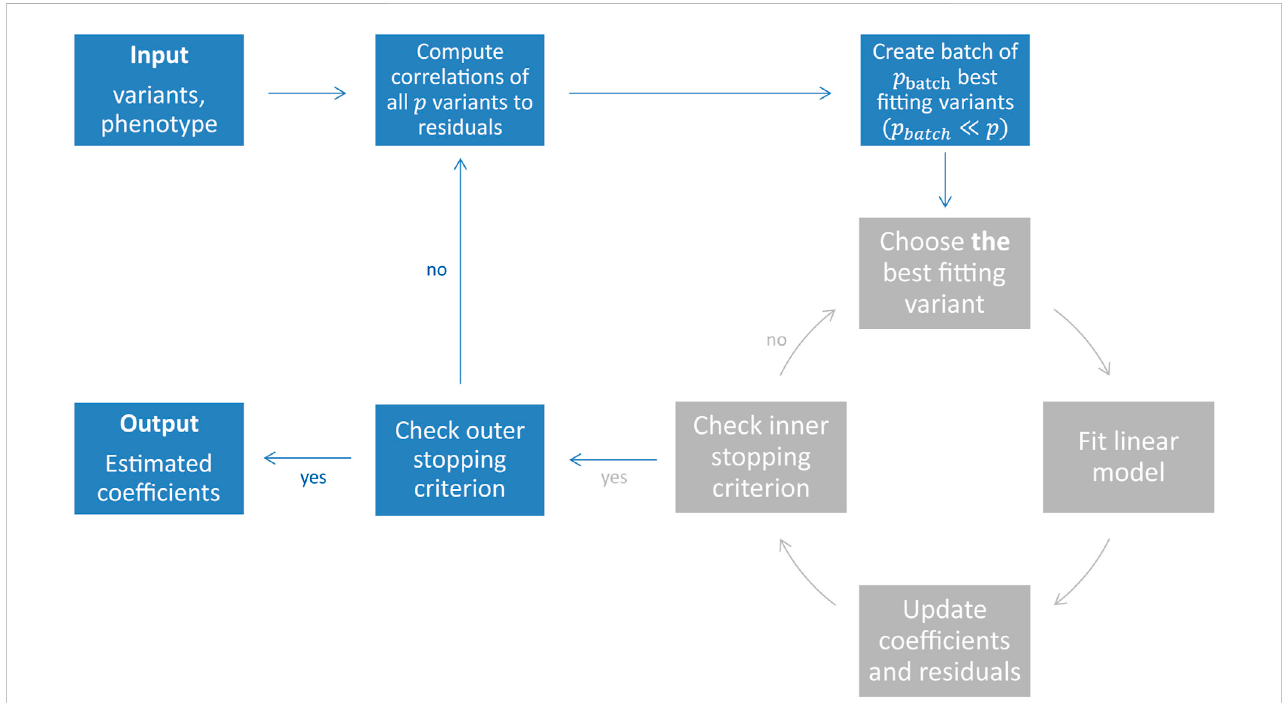
FIGURE 1 Illustrationofthesnpboostalgorithm.Thesnpboostalgorithmconsistsofanouterlooptocreatebatches(showninblue)andaninnerlooprepresenting the boosting on one batch (shown in grey).